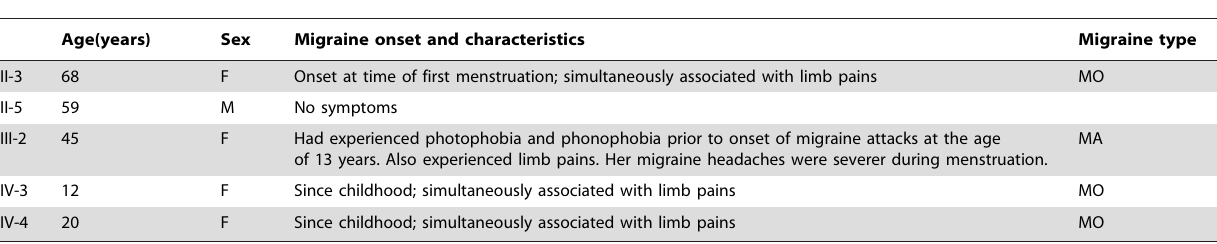
Table 3. Profile of family